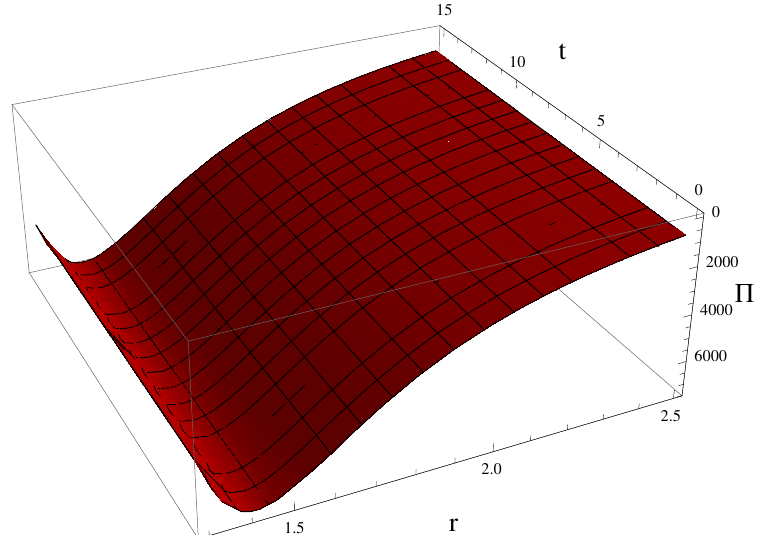
Figure 4. Anisotropic factor ( Π ) of self-gravitating compact objects via schematic diagrams for a suitable value of model parameter α , such as α = 0.99. One can examine through this diagram that, by increasing the values of r and t , the system enters into an anisotropic